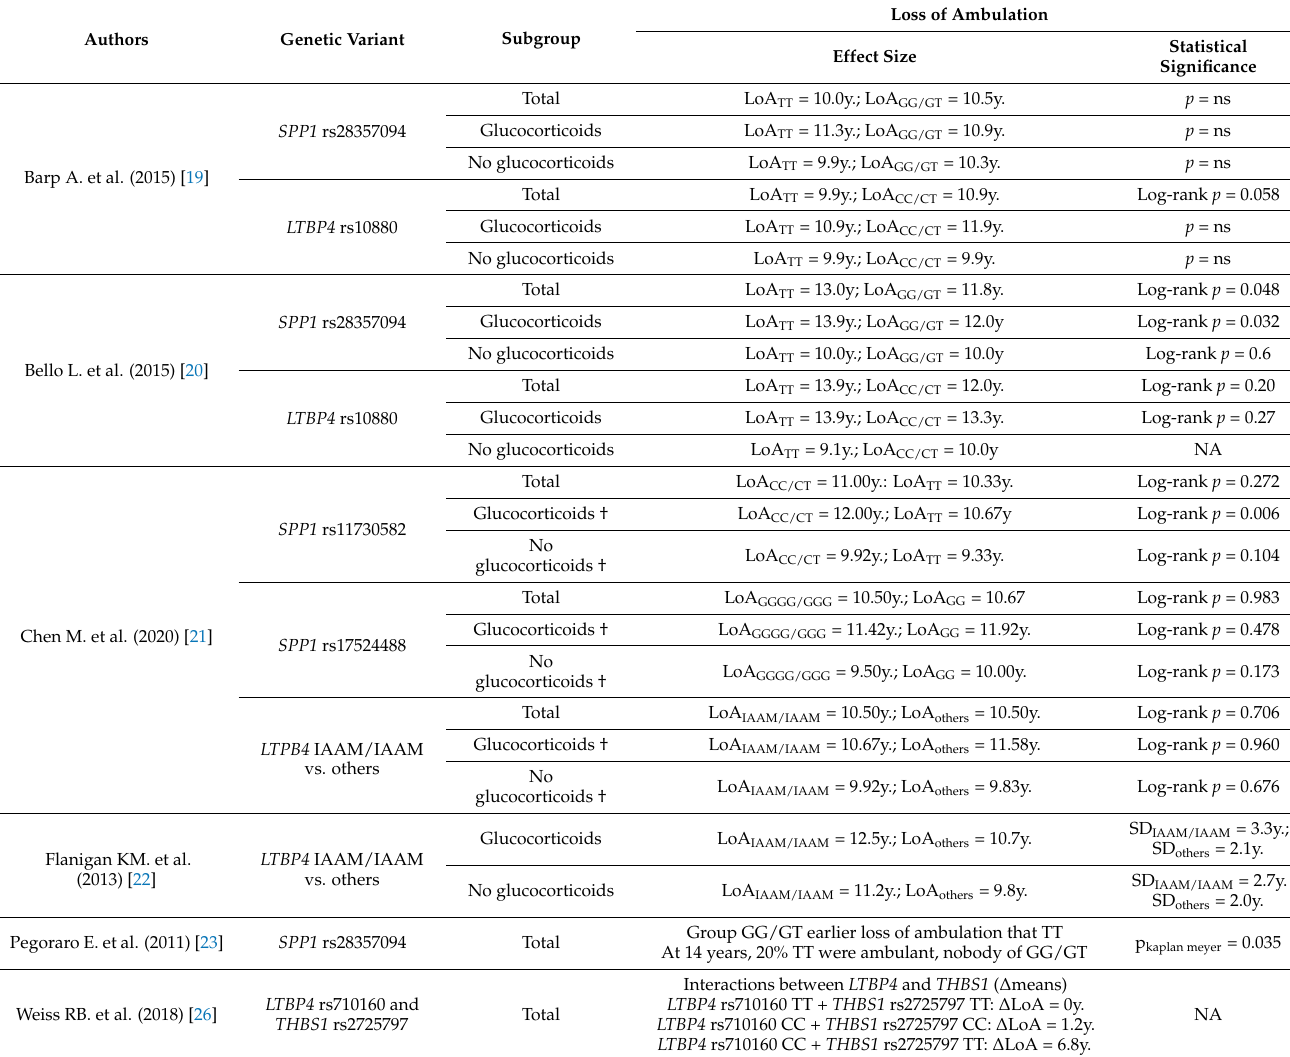
Table 2. Studies including as outcome age of loss of ambulation (Kaplan–Meier